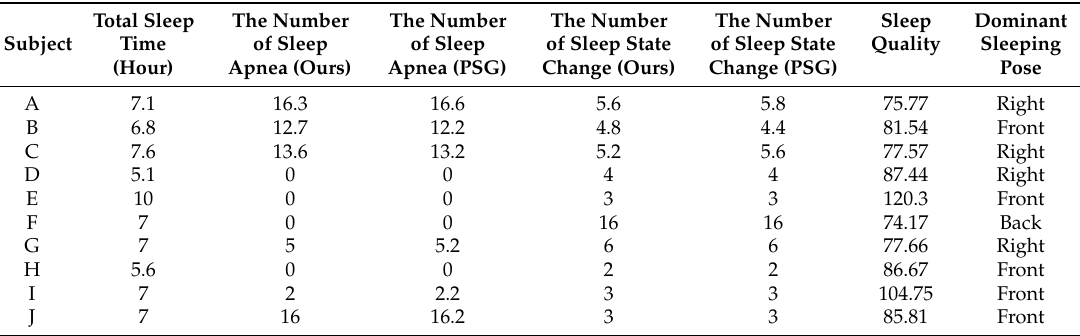
Figure 11. Results of the sleep stage classification. Table 2. Results of sleep